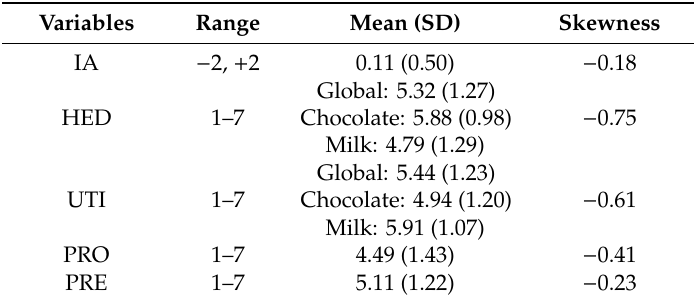
Table 4. Descriptive statistics.